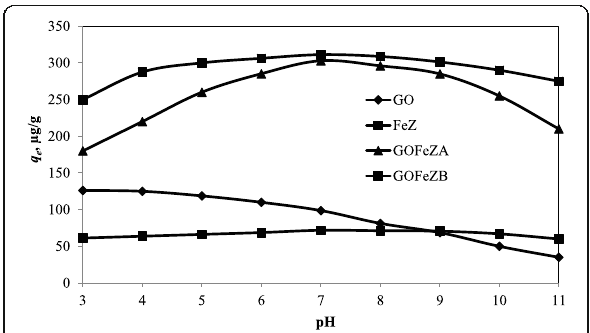
Fig. 4 The effect of pH on arsenate adsorption by GO, FeZ, GOFeZA, and